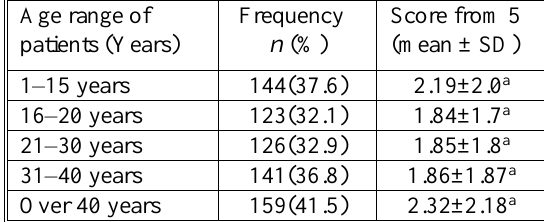
Table 2. The age ranges of patients mostly